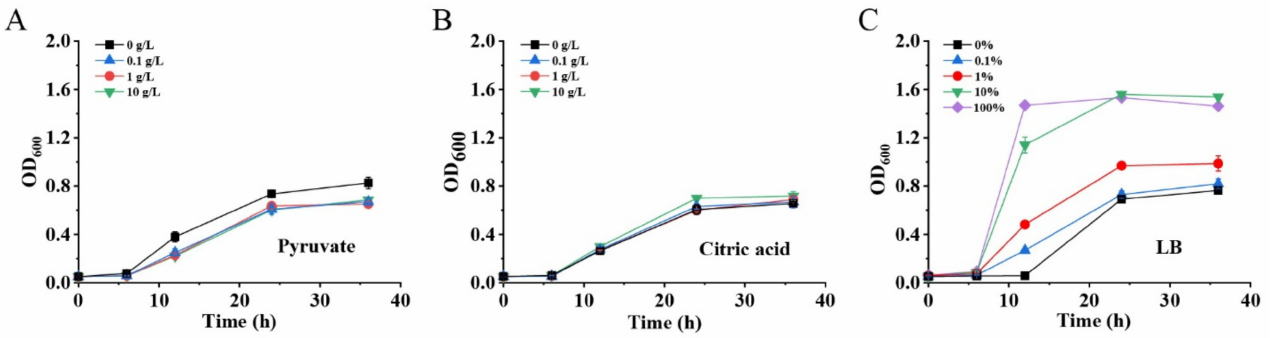
Figure 5. Effects of pyruvate ( A ), citric acid ( B ) and LB ( C ) addition on cell growth of MG1655- (DE3) ∆ pfkA ∆ pfkB ∆ zwf-